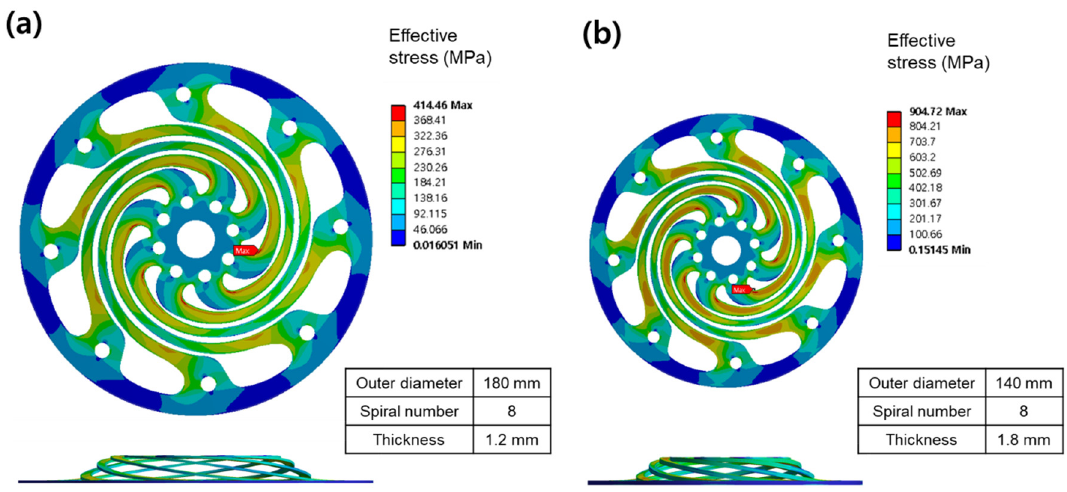
Figure 22. Results of stress analysis in the best and worst cases in CCD: ( a ) case 4 and ( b ) case 12.